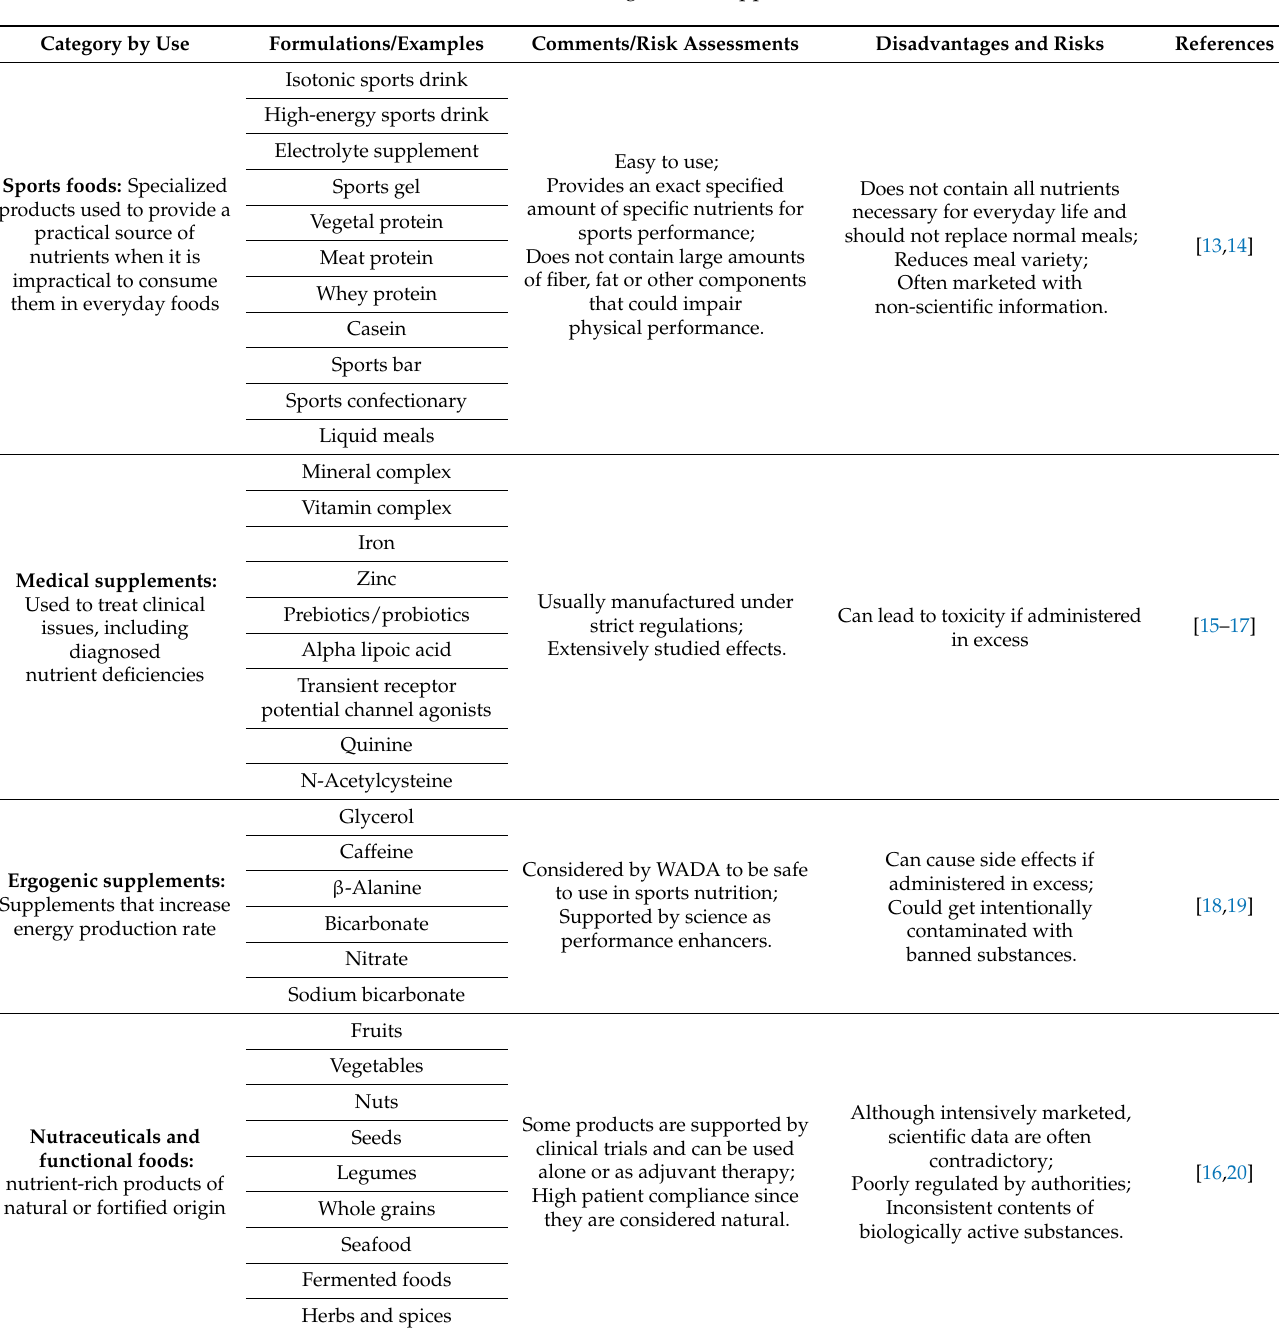
Table 2. The most common categories of